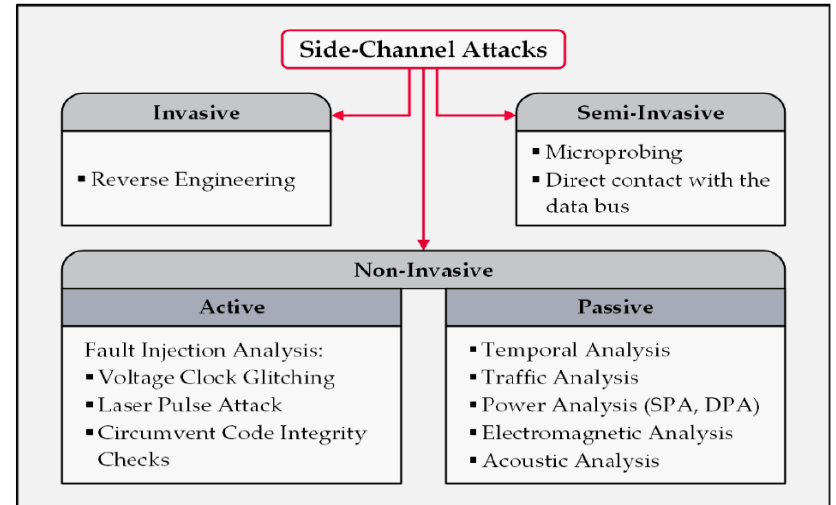
Figure 4. Taxonomy of the side-channel attacks on cyber – physical systems.